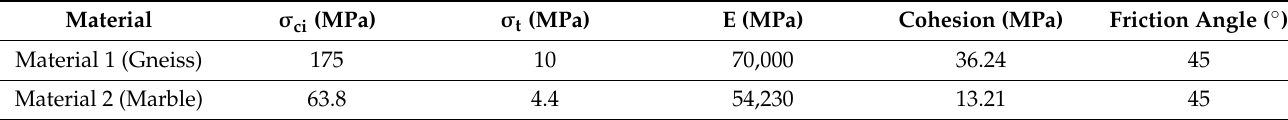
Table 2. The list of examined materials and some of their main properties.